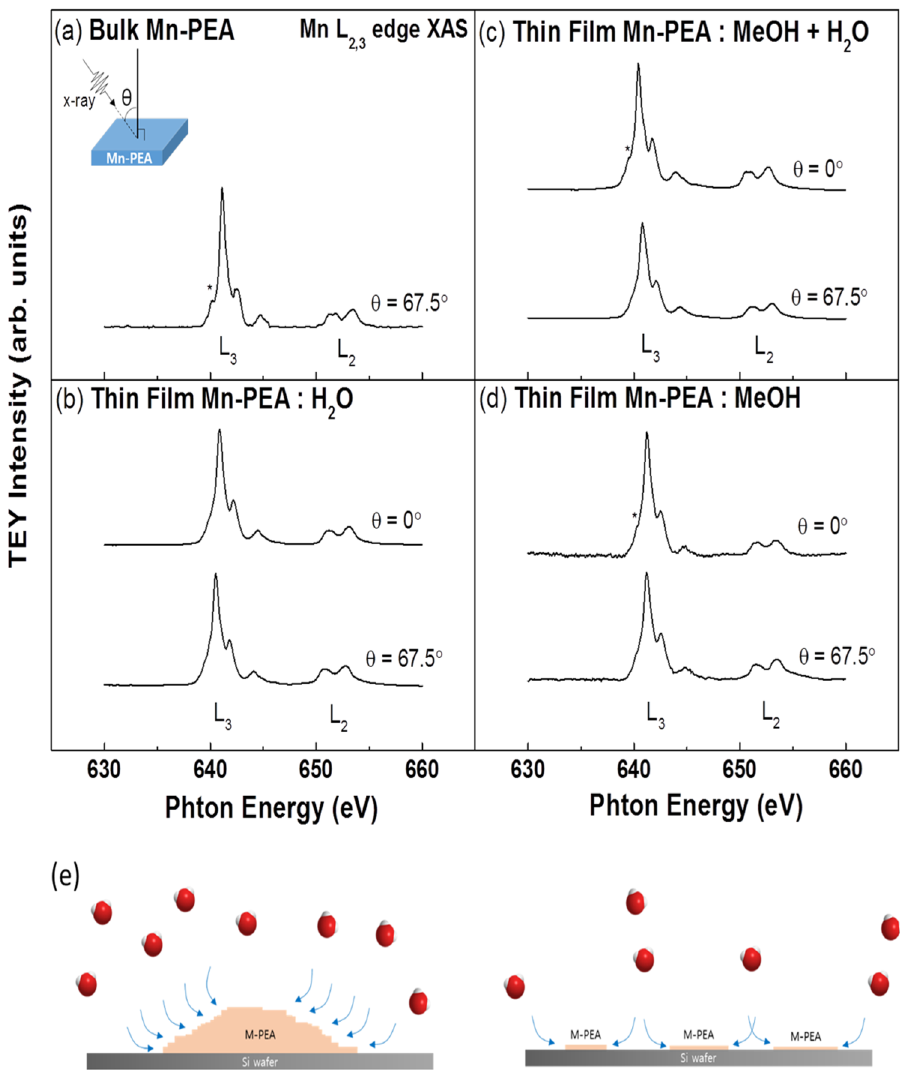
Figure 5. Mn L 2,3 edge absorption spectra taken in TEY mode at temperature lower than 44 K on ( a ) bulk single crystal Mn-PEA, ( b ) Mn-PEA thin film made from water solvent (Mn-PEA:H 2 O), ( c ) Mn-PEA thin film made from a mixed solvent of methanol and water (Mn-PEA:MeOH + H 2 O), ( d ) Mn-PEA thin film made from a methanol solvent (Mn-PEA:MeOH, RH > 50%). The inset figure in ( a ) shows the scattering geometry where two incidence angles ( θ = 0°and 67.5°) are adopted. The figure in ( e ) shows how the water molecules in the air permeate into samples having two different growth